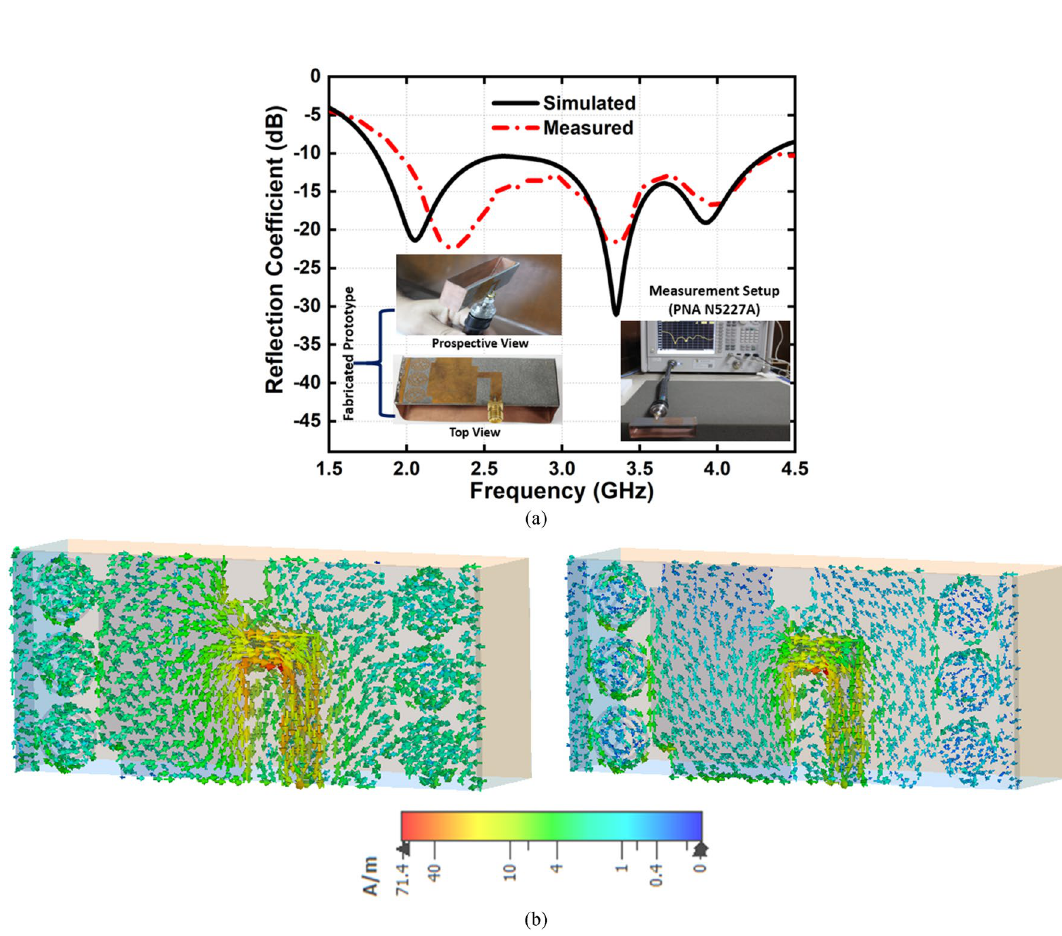
Figure 3. ( a ) Simulated and measured reflection coefficient and ( b ) surface current distribution at 2.1 GHz and 3.34 GHz,